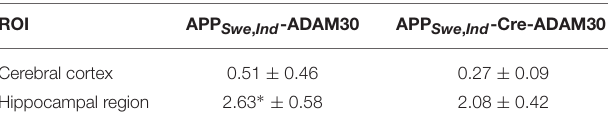
TABLE 1 | Comparative statistics between APP Swe , Ind -ADAM30 and APP